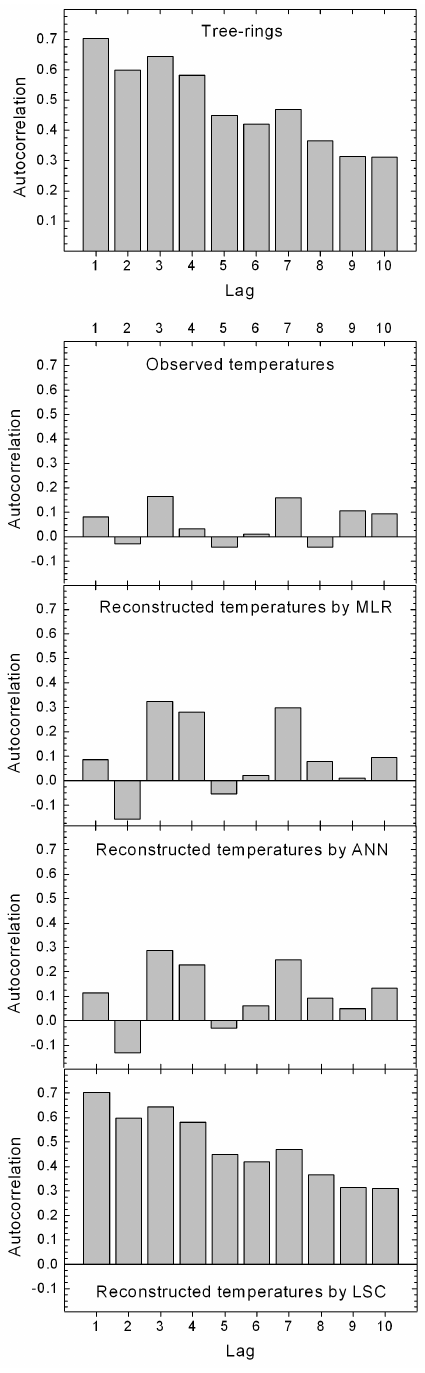
Fig. 1. Autocorrelation functions from first to tenth order for tree- rings, observed temperatures (mean July temperatures), and recon- structed temperatures using multiple linear regression (MLR), arti- ficial neural networks (ANN1 in Table 1) and linear scaling (LSC). Autocorrelations were computed using the common interval 1876–